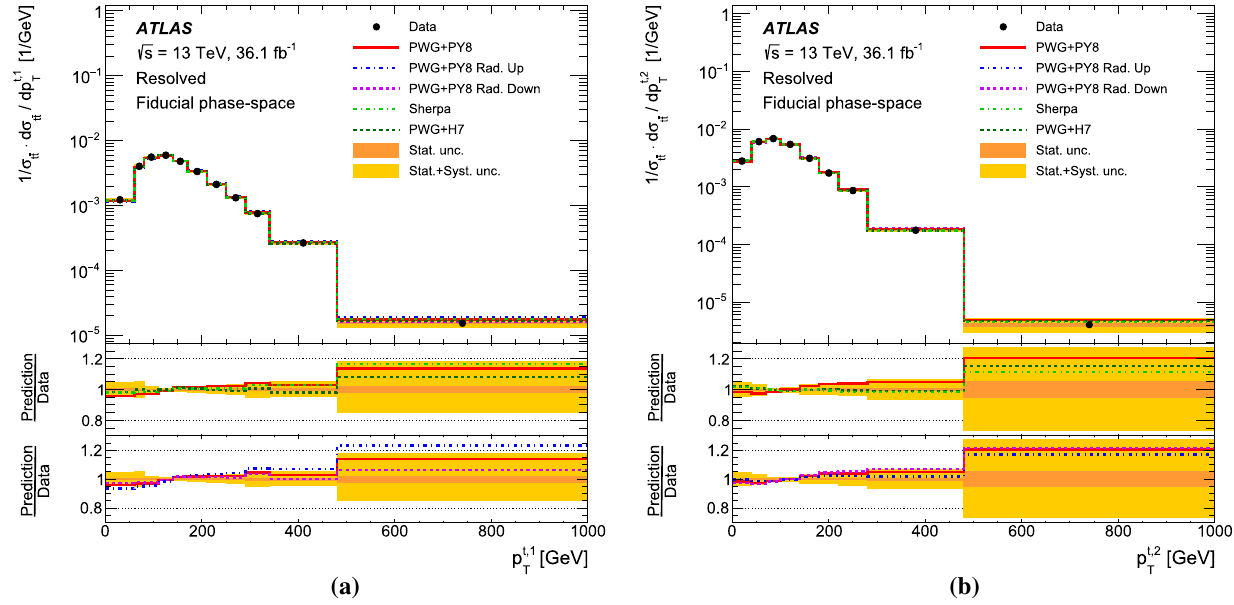
Fig. 23 Particle-level normalised differential cross-sections as a func- tion of the transverse momentum of a the leading and b the subleading topquarkintheresolvedtopology,comparedwithdifferentMonteCarlo